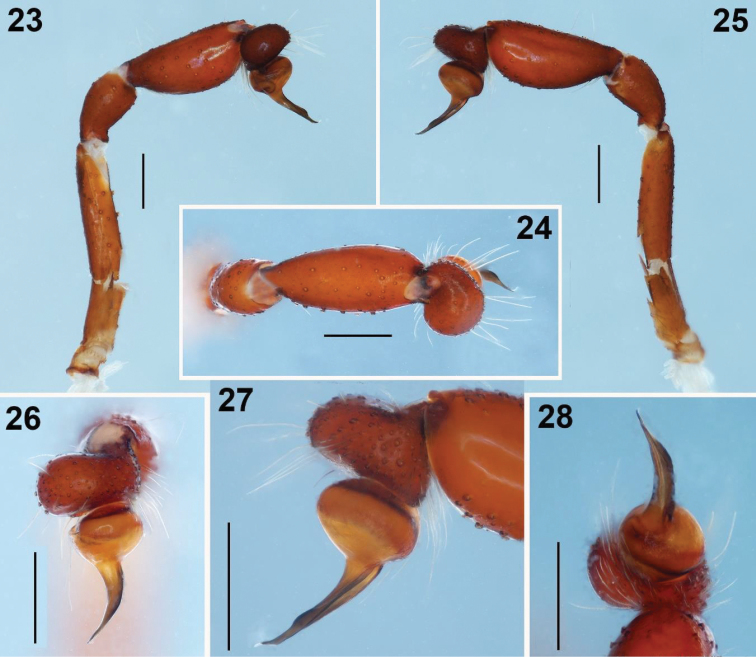
Loxosceles
tenochtitlan sp. nov. Male Holotype 23–25 left palp, prolateral, dorsal and retrolateral views respectively 26–28 detail of the bulb and embolus, dorsal, retrolateral and apical views, respectively. Scale bars: 0.5 mm (23–25), 0.2 mm (26–28).